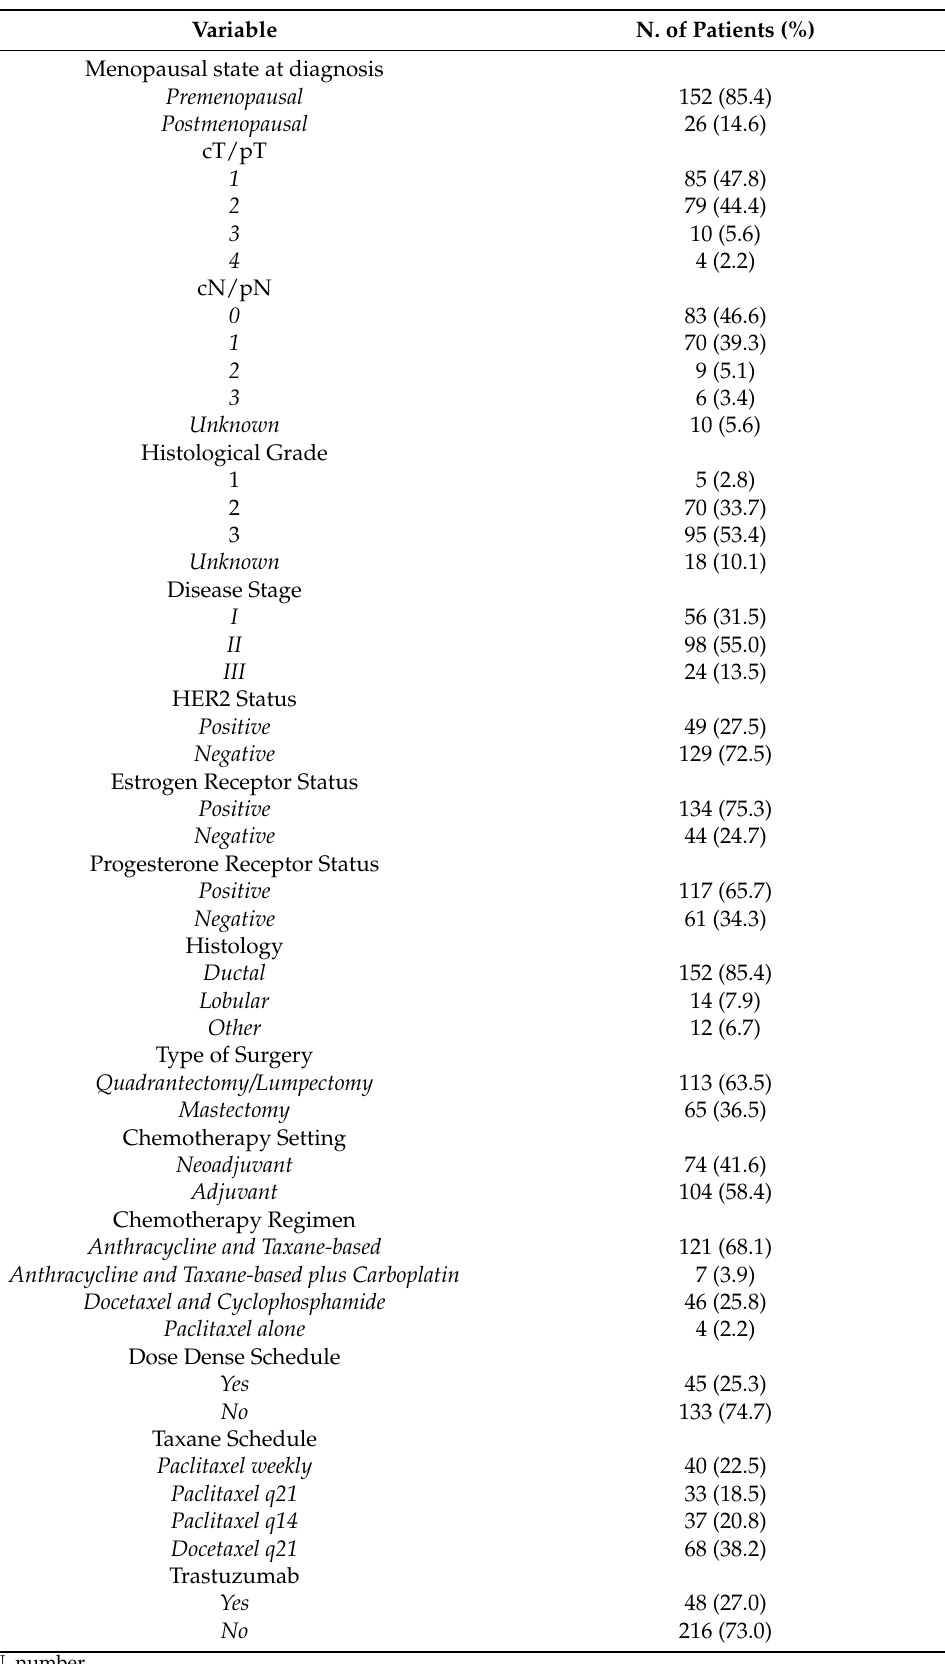
Table 1. The baseline patients’